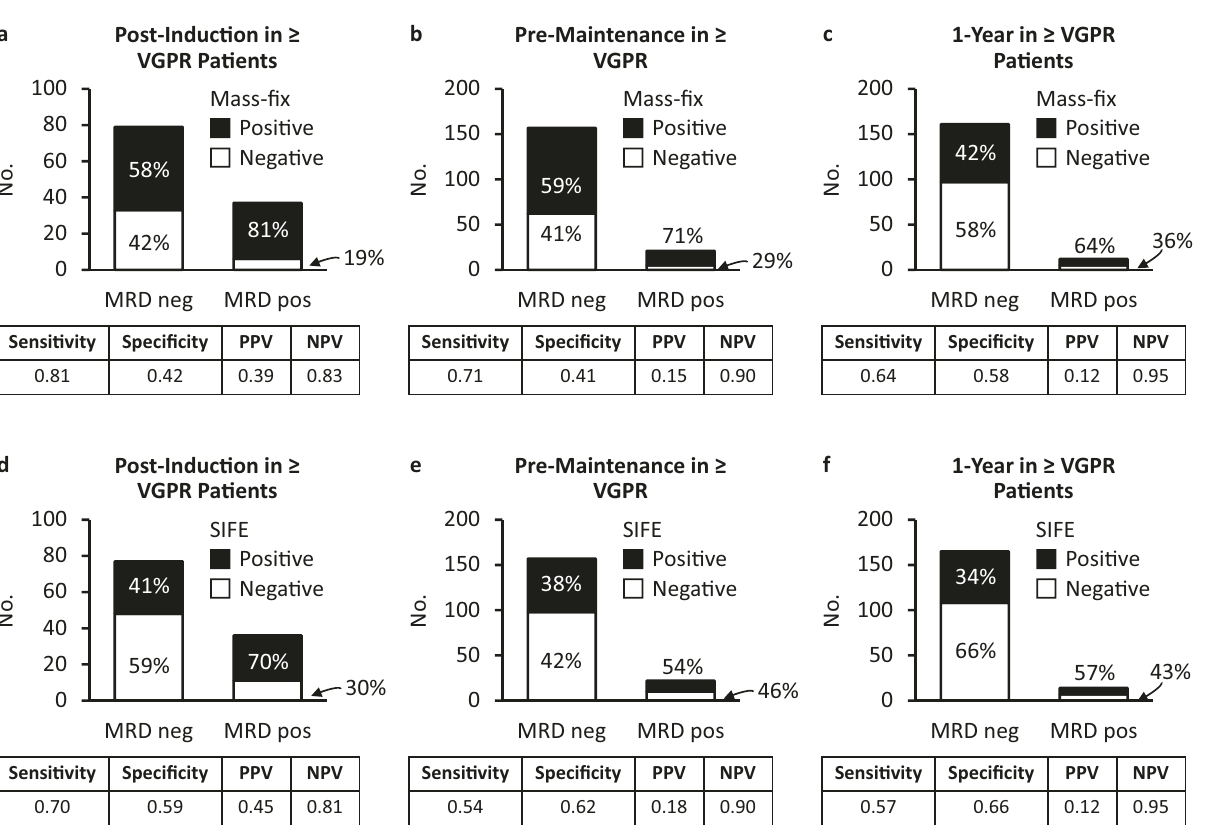
Fig. 1 Performance of serum Mass-Fix as compared to bone marrow MRD. a – c performance of Mass-Fix among patients in CR or better at 3 time points; d – f performance of SIFE among patients in VGPR or better at 3 time Response and comparison of response variables . At the 3 time points, the rates of CR (and ≥ VGPR) were as follows: Post-I, 17% (and 46%); Pre-M, 37% (and 73%); and 1YR 47% (and 84%). The rates of negative Mass-Fix among those patients achieving VGPR or better at Post-I, Pre-M, and 1YR were 42%, 41%, and 58%, respectively. The respective rates of negative SIFE for these same 3 measurement points were 59%, 62%, and 66%. Rates of MRD negativity at the three time points, among those patients